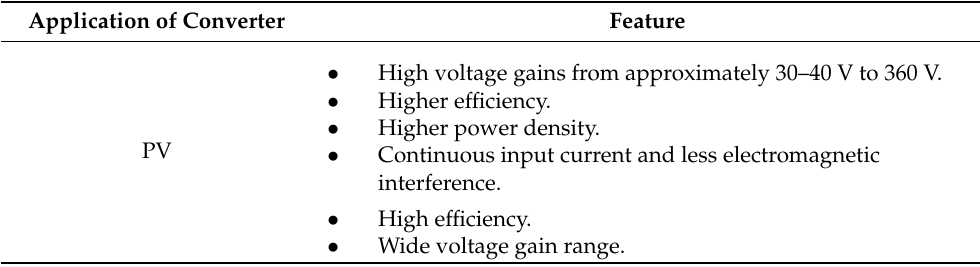
Table 7. Summary of applications in step-up and step-down DC–DC